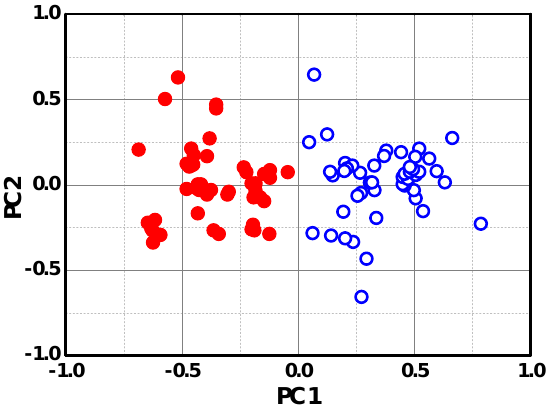
Figure 9. PCA score plot of modulated Raman spectra for 50 normal (blue circle) and 50 bladder cancer cells (red dot) acquired with a laser power of 200 mW, a modulation amplitude of 160 GHz, a sampling rate of three, a number of cycles of one, a time constant of 2 s and a total acquisition time of 6 s